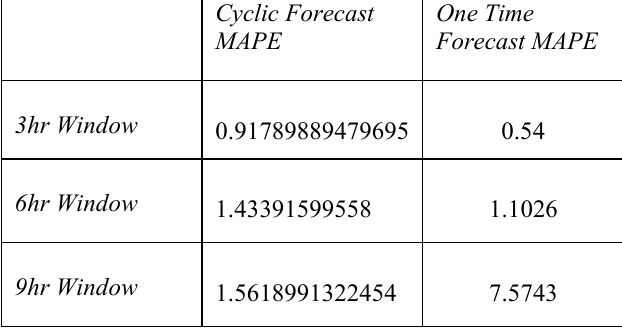
Table 2. Table showing MAPE scores for Cyclic and One Time Forecast